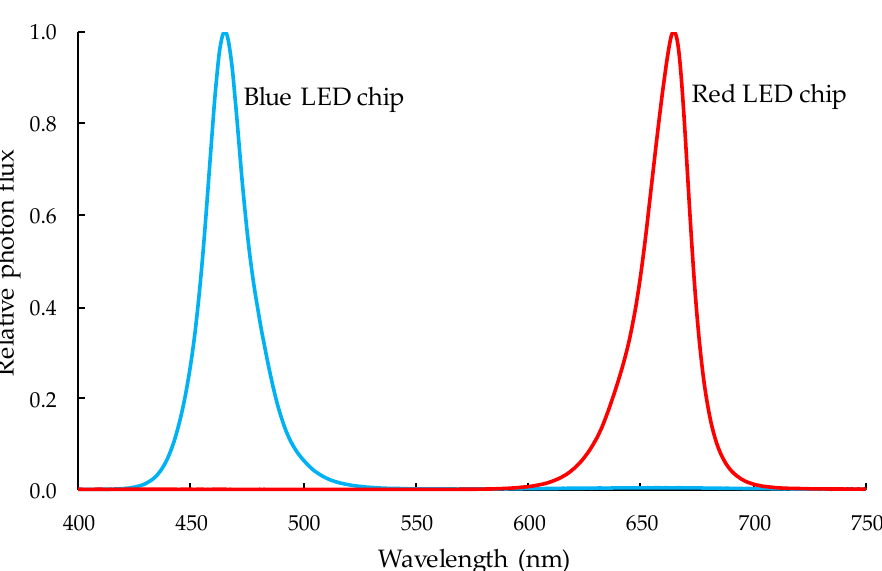
Figure 3. The relative spectral photon distribution of blue and red LED chips (Showa Denko K.K., Tokyo, Japan) measured by a spectroradiometer (USR-45DA, USHIO Inc., Tokyo, Japan). The blue LED chip had a peak wavelength at 466 nm, and the red LED chip had a peak wavelength at 665 nm. The maximum values of blue and red LED chips were converted to 1.0 separately. The maximum photosynthetic photon flux values of blue and red LED chips per lamp were 13.4 µ mol s − 1 / lamp and 38.9 µ mol s − 1 / lamp, respectively. The full widths at half maximum of radiation spectra of blue and red LED chips were 22 and 22 nm, respectively.